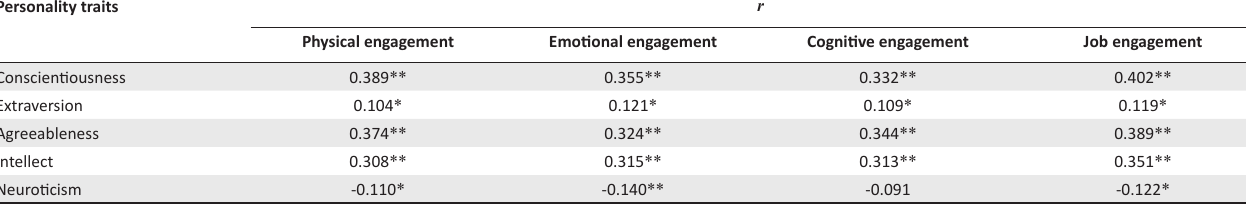
TABLE 2 : Pearson correlation coefficients ( r ) for relations of personality traits and job engagement. Personality